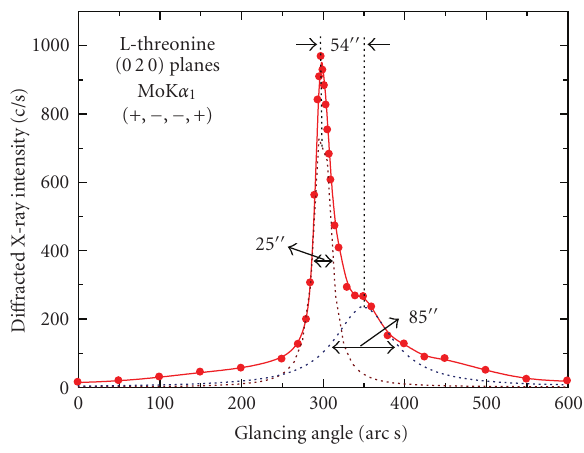
Figure 29: HRXRD curve recorded for L-threonine single crystal grown at isoelectric pH for (0 2 0) di ff racting